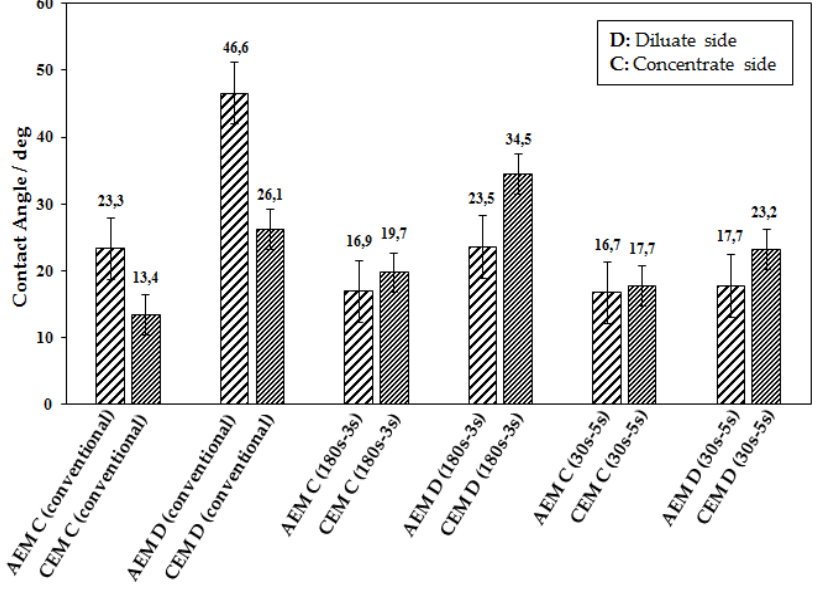
Figure 3. The values of the measured contact angles on the membranes surface after each ED of whey with different regimes.